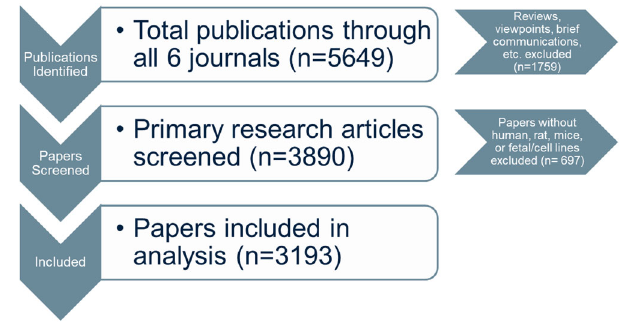
Fig. 1 Total number of papers sampled in 2009 and 2019 across six journals in neuroscience and psychiatry. Reviews, viewpoints, brief communications and any other non-primary research articles were excluded. A total of 2456 studies did not match the inclusion criteria and were excluded. Only primary research articles containing human, rat, mice, fetal or cell lines were analysed further ( n = 3193).